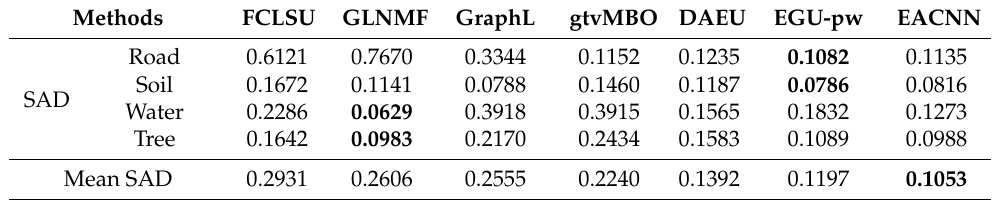
Table 4. Experimental results for the Jasper Ridge dataset.